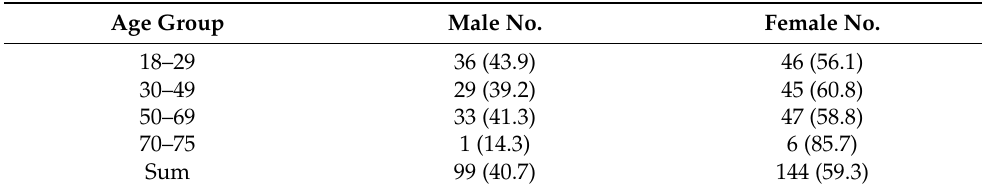
Table 1. Age and sex distribution of the study participants (n = 243).